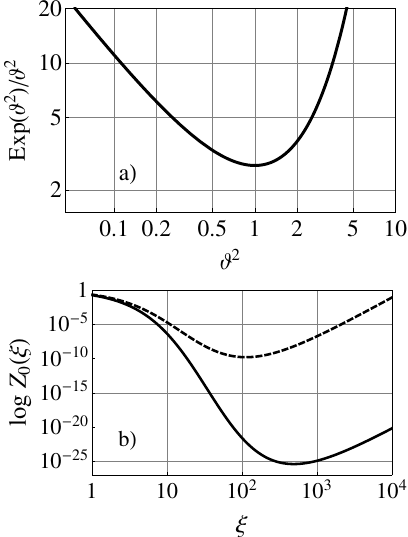
Figure 7. Illustration of the left and right hand sides of Eq. (31). In (a) we have the left side as a function of ϑ 2 and in (b) we show Z 0 (ξ) ≡ exp ( − 2 z 0 /L)( 1 + ξL/z 0 ) 6 exp ( 2 (z 0 /L)/( 1 + ξL/z 0 )) . Note the different representations on the axes. In (b) we have the full line for L/z 0 = 0 . 025 and the dashed line for L/z 0 = 0 . 05.